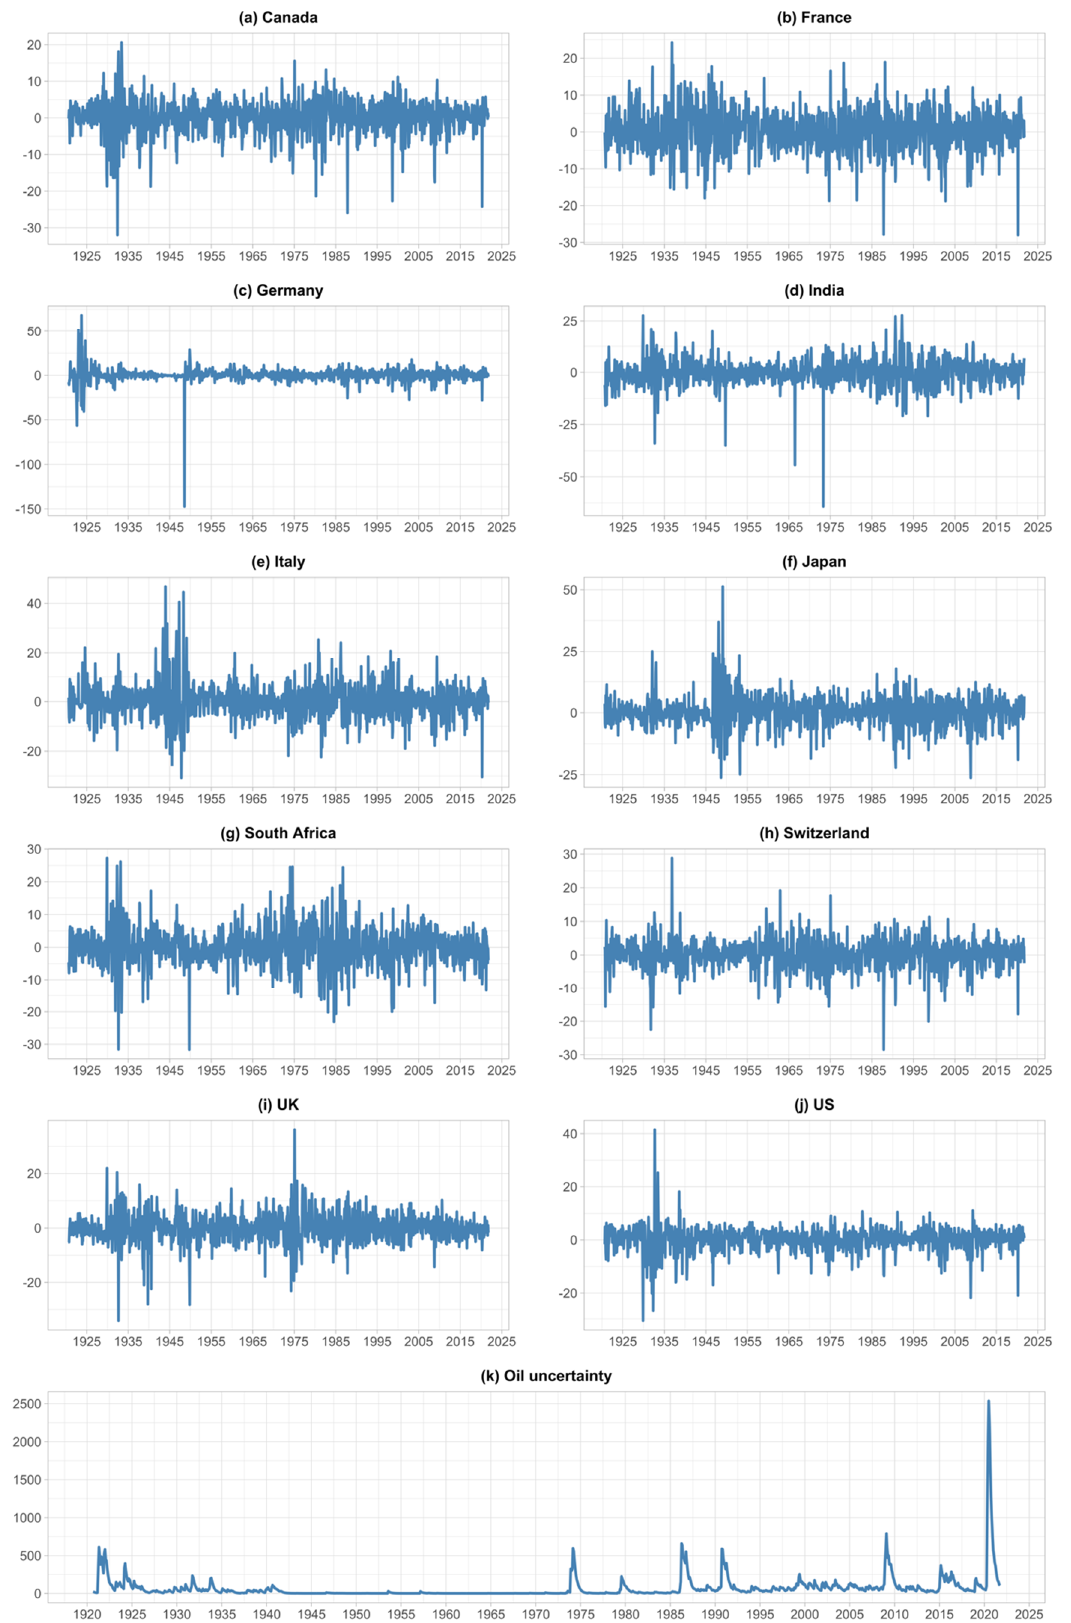
Figure A1. Stock returns and oil uncertainty series.